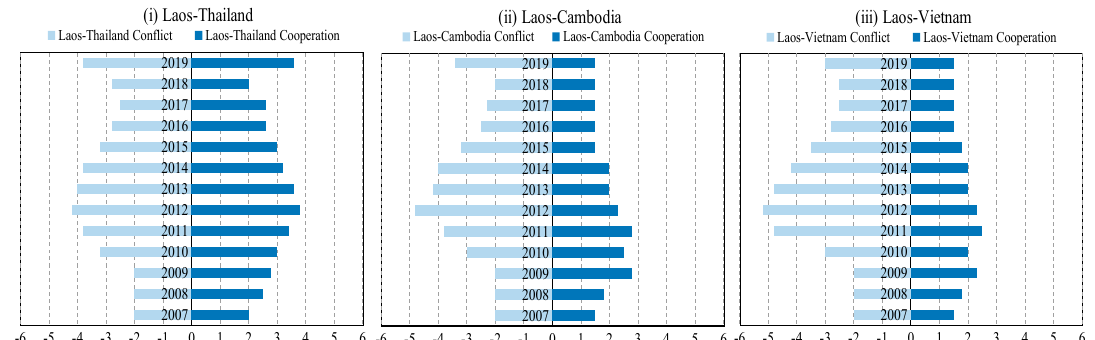
Figure 2. TWINS analysis—the evolution of the interstate relations. ( a ) Laos-Thailand, ( b ) Laos-Cambodia, ( c ) Laos-Vietnam.